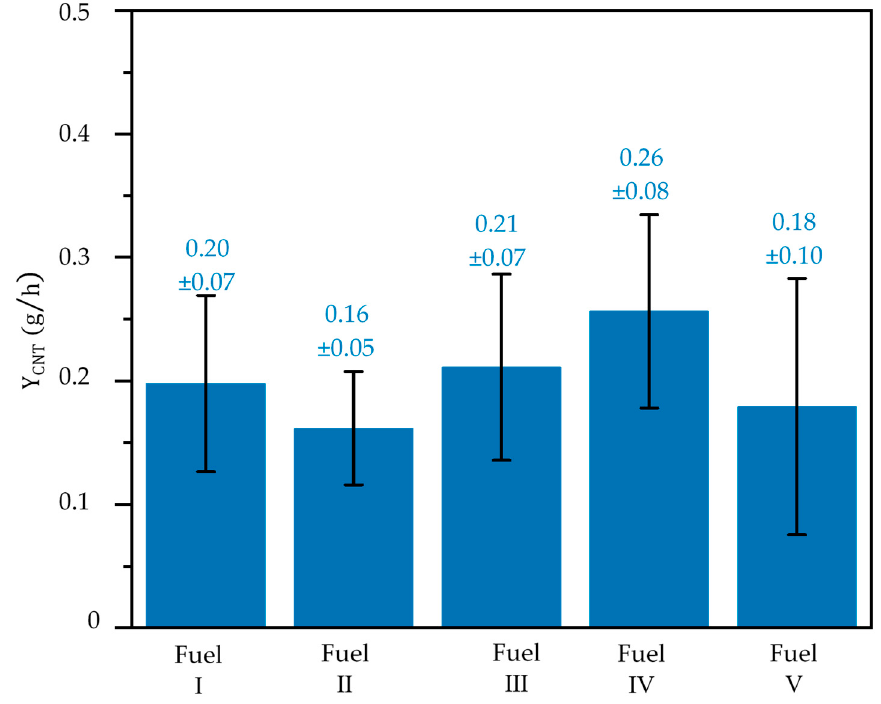
Figure 8. Yield rate obtained from five fuels I–V.